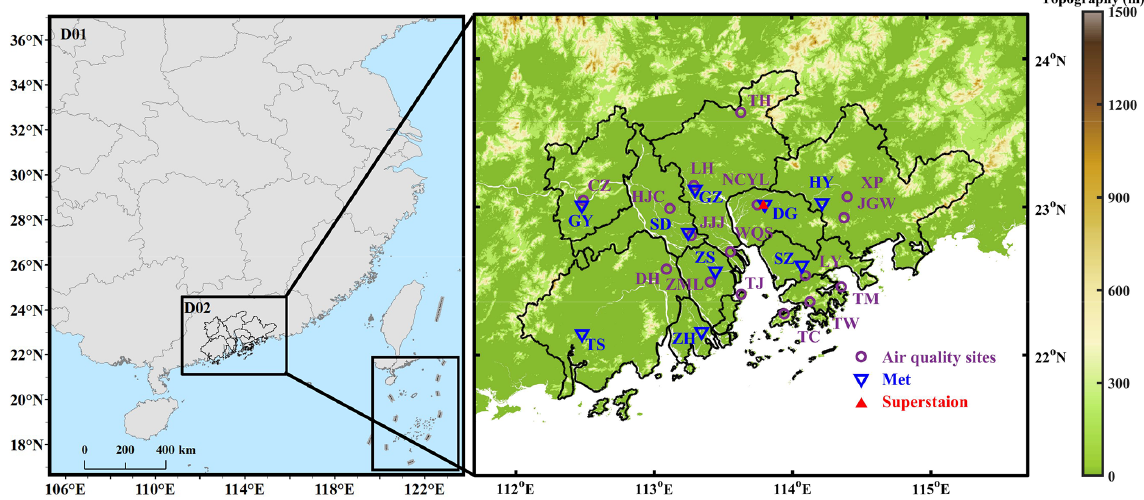
Figure 1. Model domains and locations of 16 air quality monitoring stations (purple dots), nine meteorological stations (blue triangles), and the Dongguan superstation (red triangles). The figure on the right shows the elevation of the terrain (m). The 16 air quality monitoring stations are Nanchengyuanling (NCYL), Jinjiju (JJJ), Huijingcheng (HJC), Luhu (LH), Wanqingsha (WQS), Tianhu (TH), Tap Mun (TM), Tsuen Wan (TW), Tung Chung (TC), Xiapu (XP), Jinguowan (JGW), Donghu (DH), Liyuan (LY), Tangjia (TJ), Chengzhong (CZ), and Zimal- ing (ZML). The nine meteorology sites are Dongguan (DG), Shunde (SD), Guangzhou (GZ), Huiyang (HY), Taishan (TS), Shenzhen (SZ), Zhuhai (ZH), Gaoyao (GY), and Zhongshan